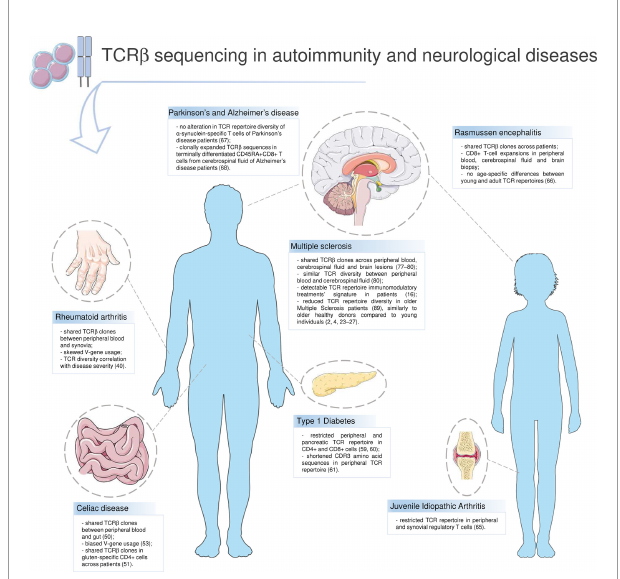
FIGURE 2 | T-cell receptor repertoire in autoimmunity and neurological diseases. Highlights on current knowledge about the TCR repertoire and the T-cell compartment in autoimmune diseases (Rheumatoid arthritis, Celiac disease, Type 1 Diabetes, Multiple Sclerosis) and in other disorders in which T lymphocytes have a role (Rasmussen encephalitis, Juvenile Idiopathic Arthritis, Parkinson ’ s and Alzheimer ’ s disease). Parts of the image created using pictures from Servier Medical Art